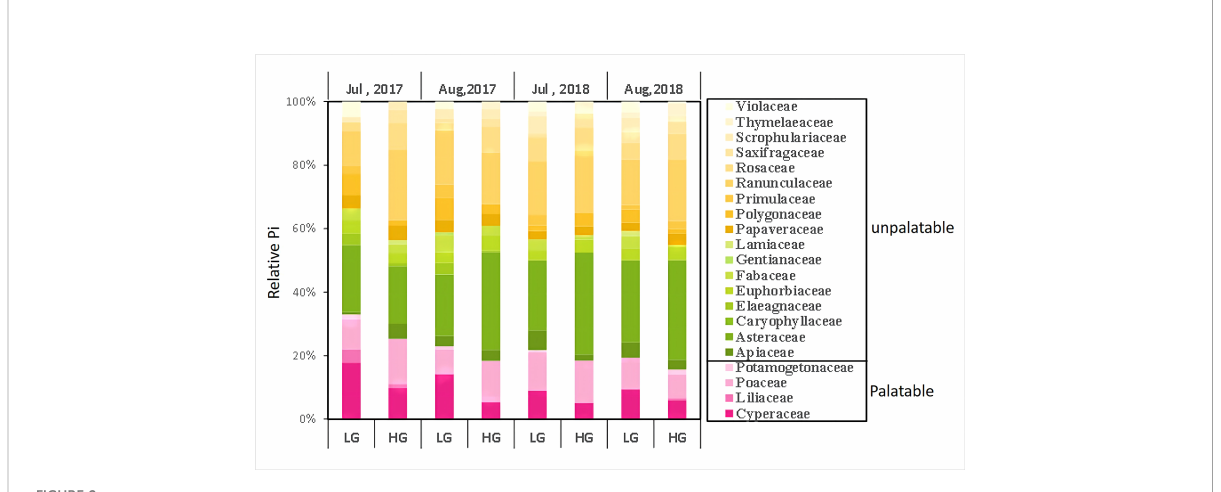
FIGURE 2 Changes in the proportion of different families in the